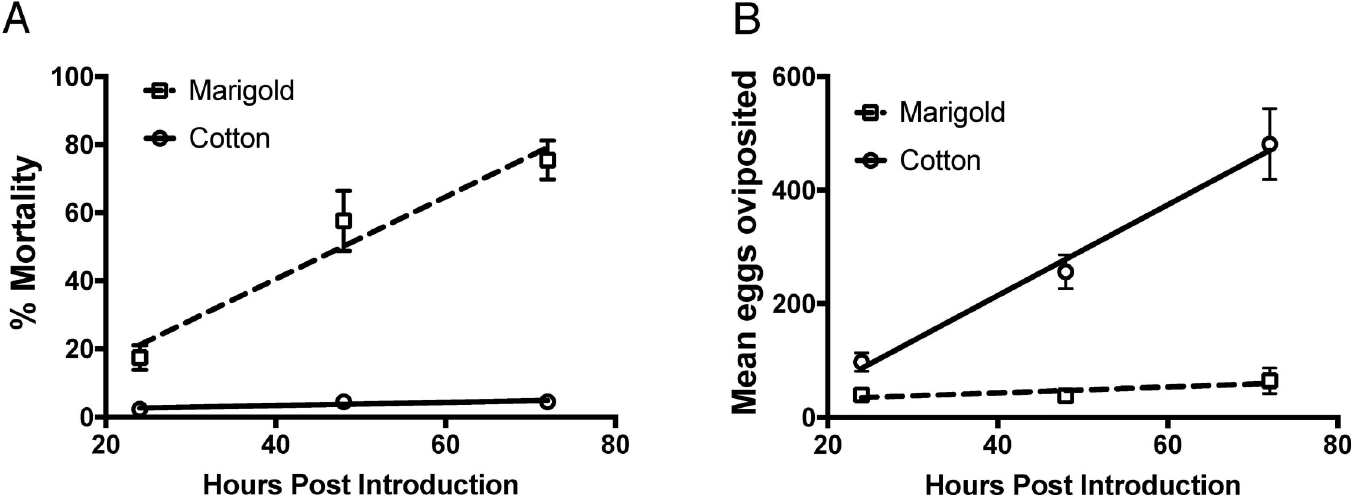
Fig 3. Mortality (A) and oviposition (B) of adult Bemisia tabaci on Tagetes patula L. (marigold) and Gossypium hirsutum L. (cotton). Lines indicate the linear regressions and bars represent standard errors.